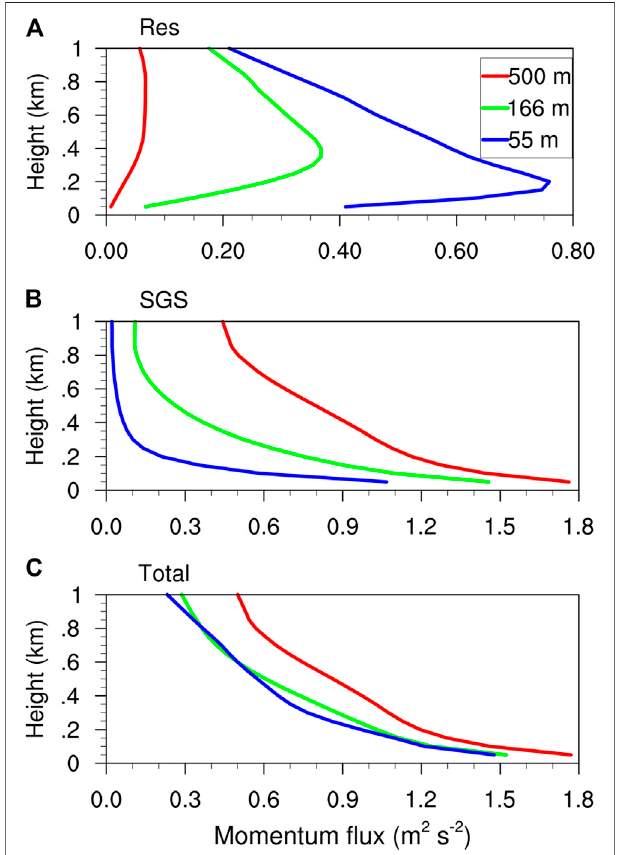
FIGURE 13 | Vertical pro fi les of (A) SGS, (B) resolved and (C) total turbulent vertical momentum fl uxes at t (cid:2) 9 h of the simulation from the grid spacing of 500, 166, and 55 m, averaged in the radius of 41.25 km from the storm center (namely, in the d06 domain).